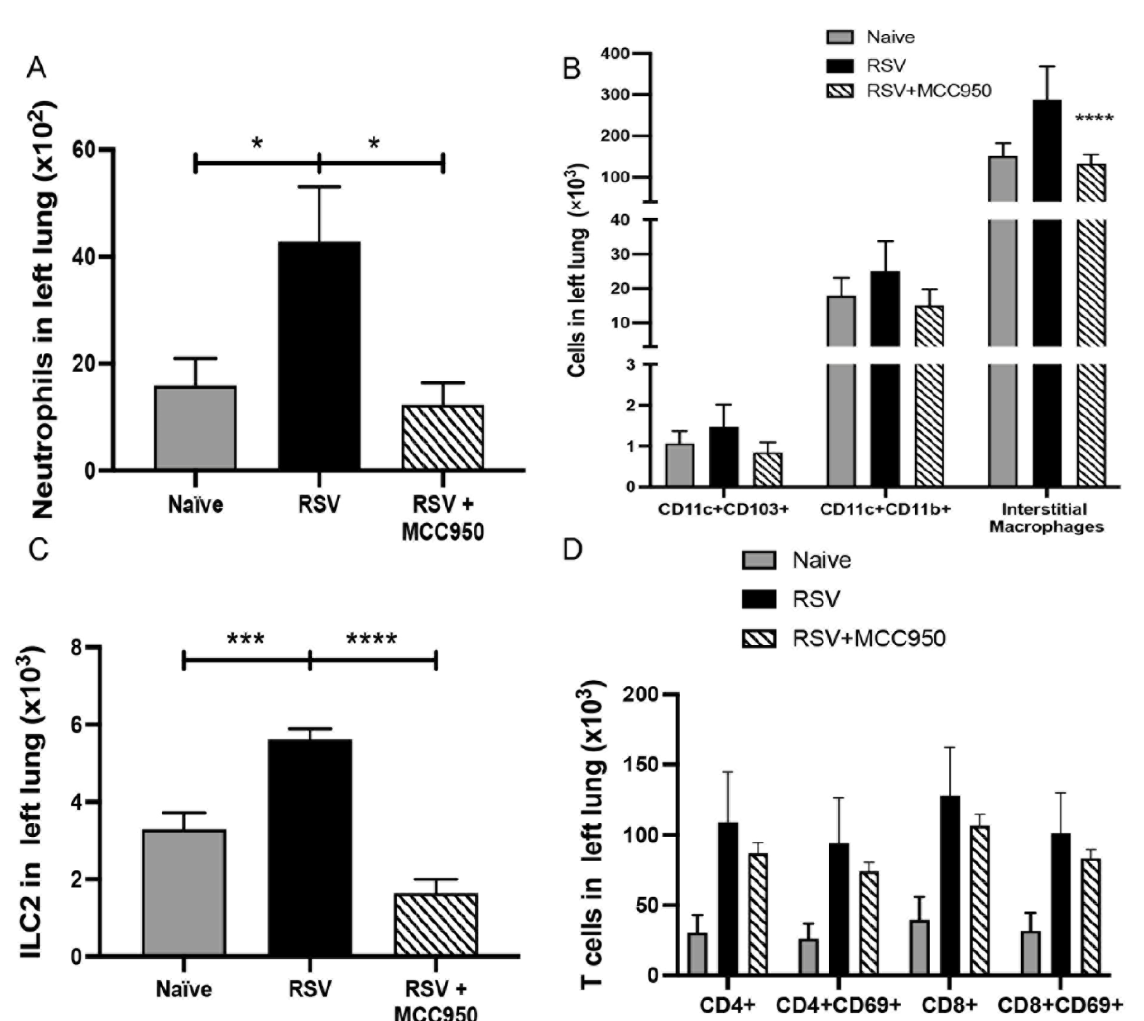
Figure 4. NLRP3-inflammasome inhibition modifies RSV inflammatory response in neonate mice. Neonatal mice were infected with RSV and treated with MCC950 or vehicle. Flow cytometry of the lung leukocytes: ( A ) Total neutrophils ( B ) Antigen-presenting cells ( C ) Type 2 innate lymphoid cells (ILC2) ( D ) T cells. Data represent the Mean ± SEM from 4 to 5 mice (experimental repeats 2). * p ≤ 0.05, *** p ≤ 0.001, **** p ≤ 0.0001.